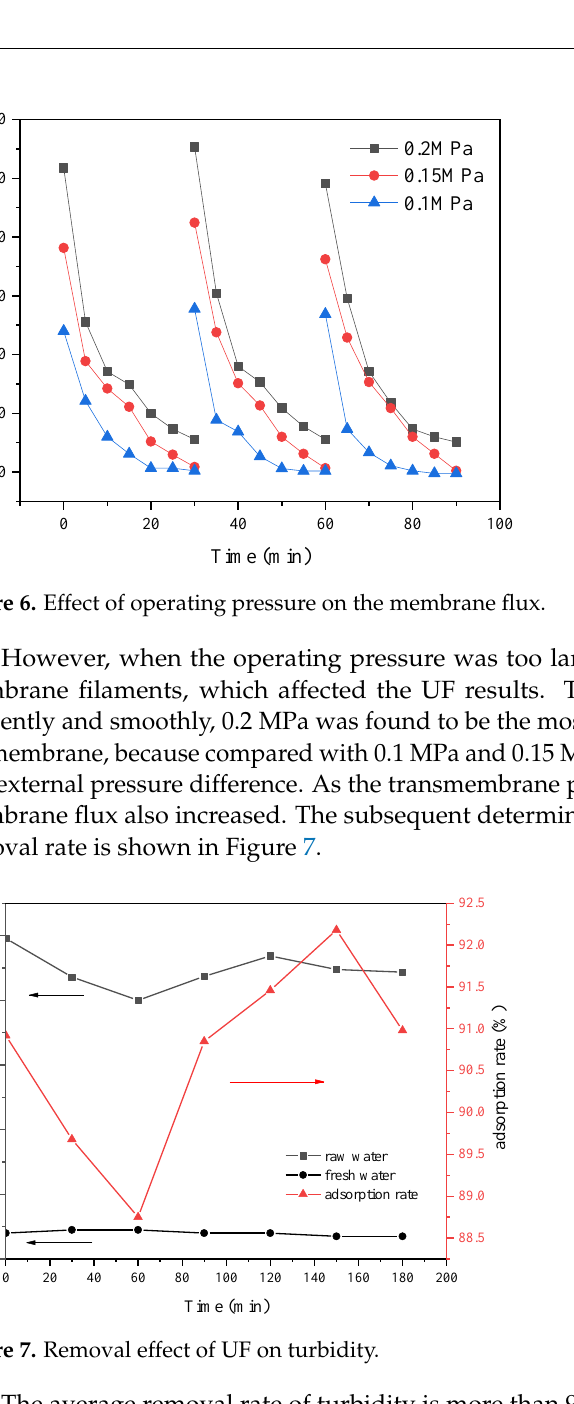
Figure 7. Removal effect of UF on turbidity.